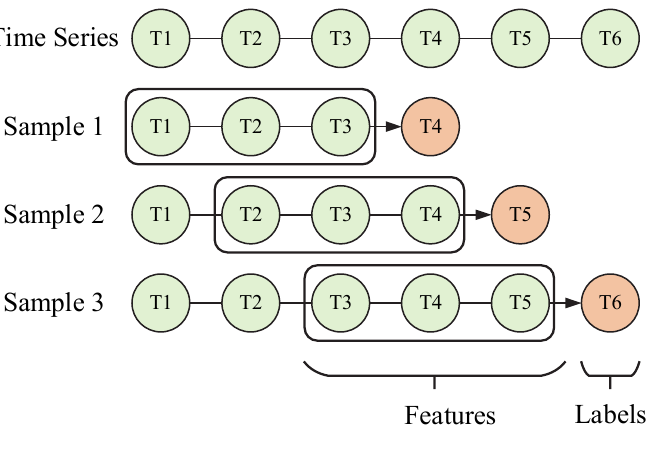
Figure 4. Sliding window